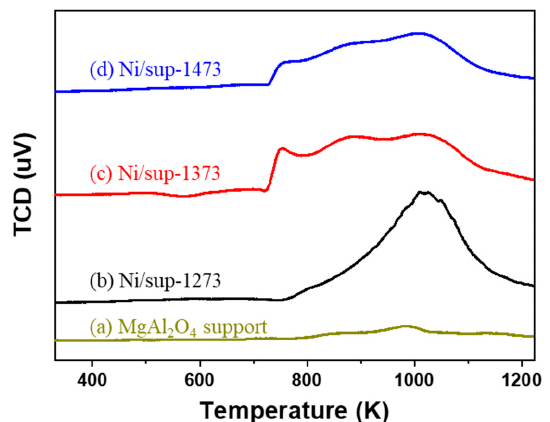
Figure 7. TPR profile of MgAl 2 O 4 support and the egg-shell-type Ni/MgAl 2 O 4 pellet catalysts.